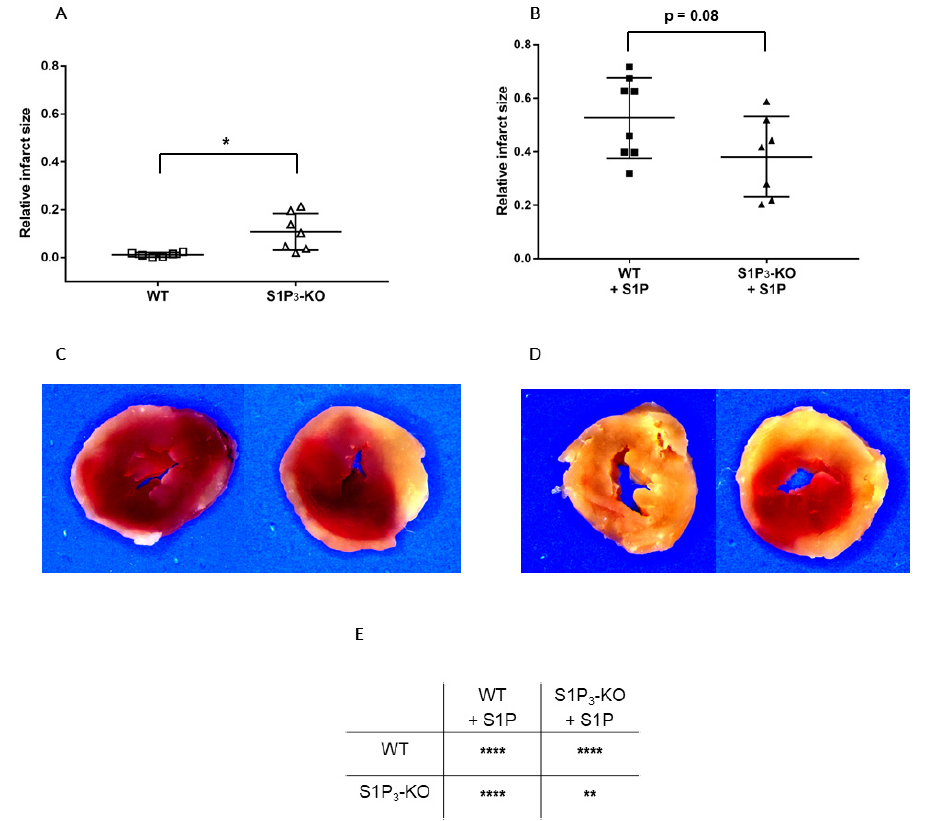
Figure 6. Relative infarct size ( A , B ) and representative sections ( C , D ) from hearts subjected to ischemia / reperfusion without (A & C) or with (B & D) 10 − 6 M S1P infusion. Mean ± SEM; n = 6, 8, 7, 7; * p < 0.05, ** p < 0.01, **** p < 0.0001, with unpaired t -test ( A , B ) or two-way ANOVA and Sidak’s multiple comparison test ( E ).